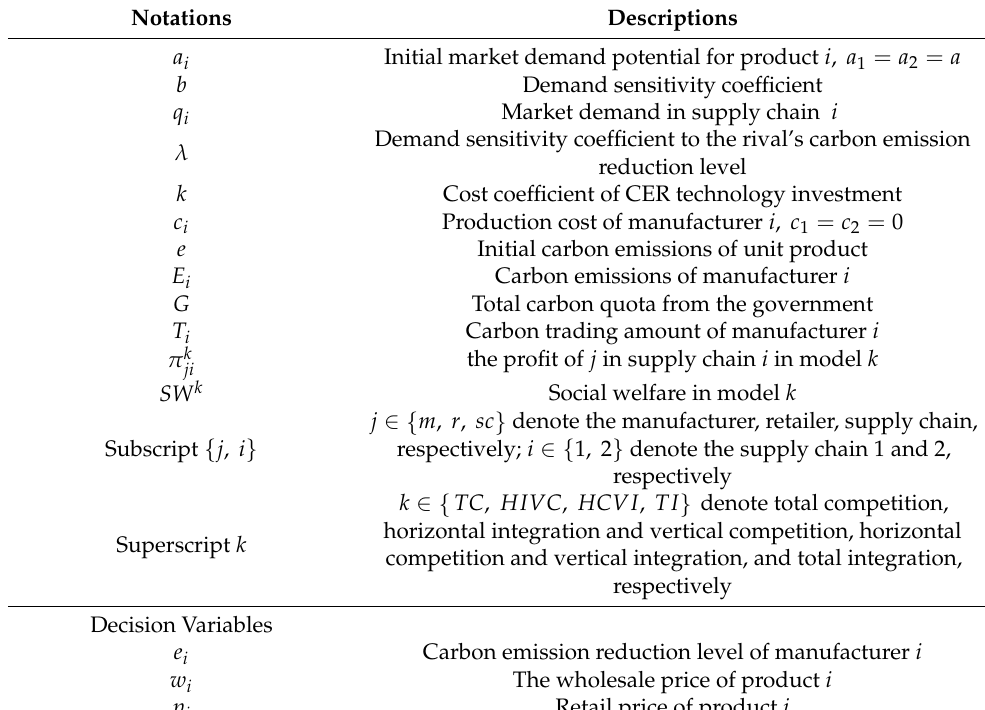
Table 2. The notations used in this